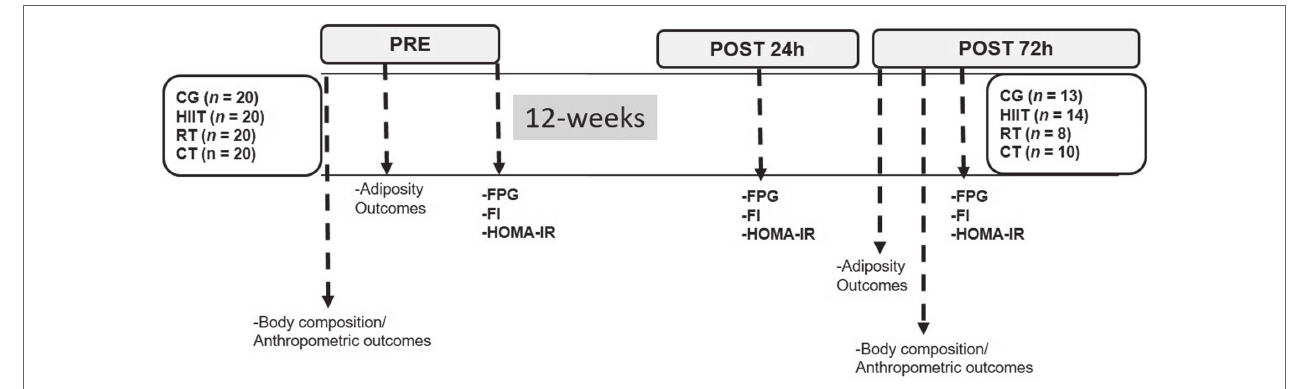
FIGURE 2 | Study protocol. Groups are described as control group (CG), high-intensity interval (HIIT), resistance training (RT), and concurrent training (CT). Outcomes are described as fasting plasma glucose (FPG), fasting insulin (FI), and homeostasis model assessment on insulin resistance